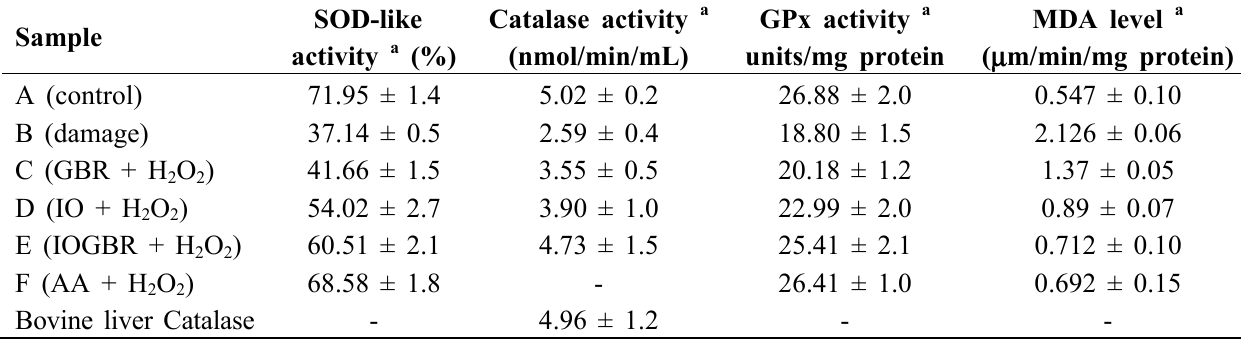
Table 1. Superoxide dismutase (SOD), glutathione peroxidase (GPx), and catalase (CAT) activities and malondialdehyde (MDA) level with and without the treatment of Inonotus obliquus (IO), germinated brown rice (GBR) and Inonotus obliquus grown on germinated brown rice (IOGBR) in mice liver damaged by H catalase were used as positive